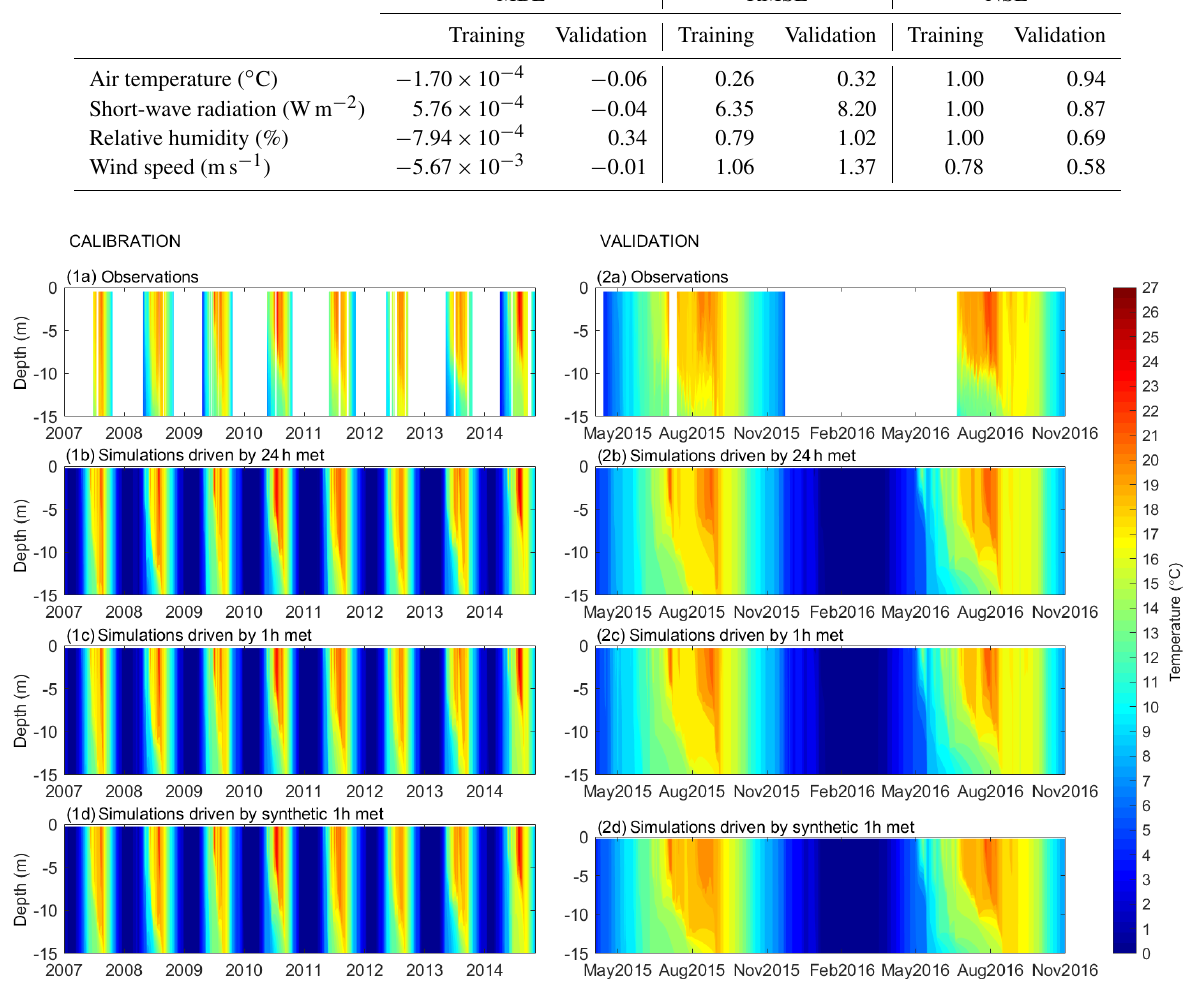
Figure 2. GOTM water temperature simulations. Daily averaged water temperature in Lake Erken for the following calibration (1a–1d) and validation (2a–2d) periods: observations (1a, 2a) , simulations driven by daily meteorological data (1b, 2b) , hourly meteorological data (1c, 2c) , and synthetic hourly meteorological data (1d, 2d)